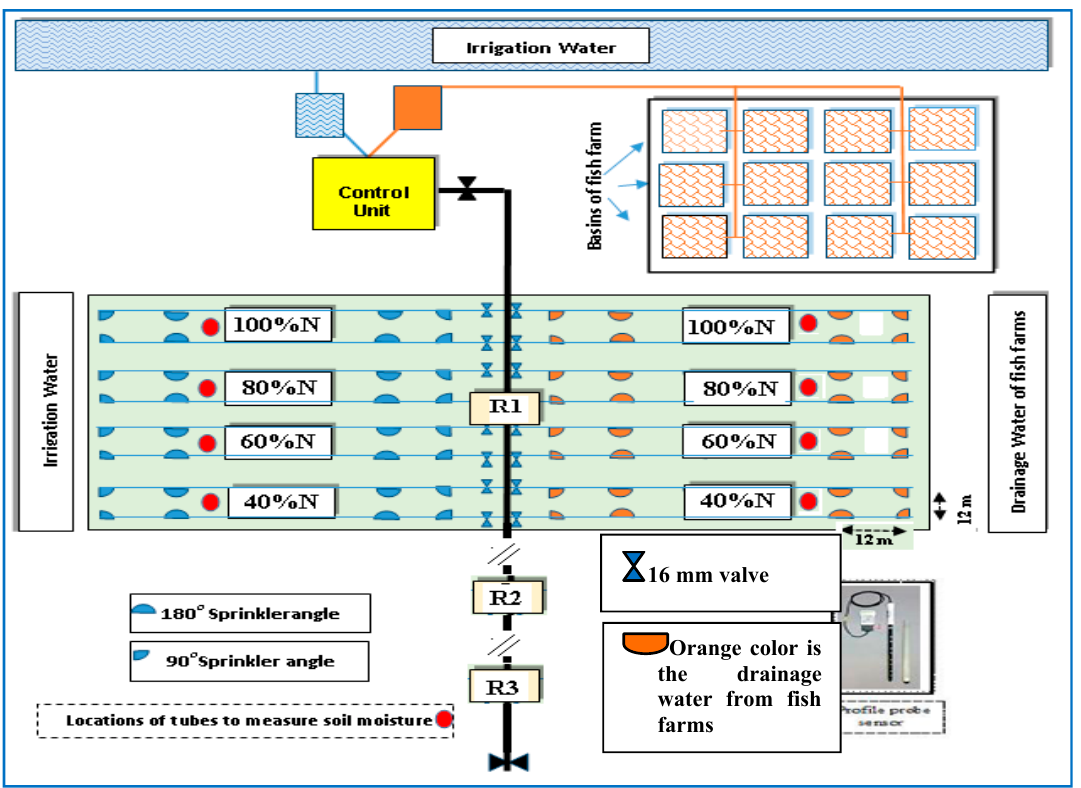
Figure 2. Layout of experimental design.